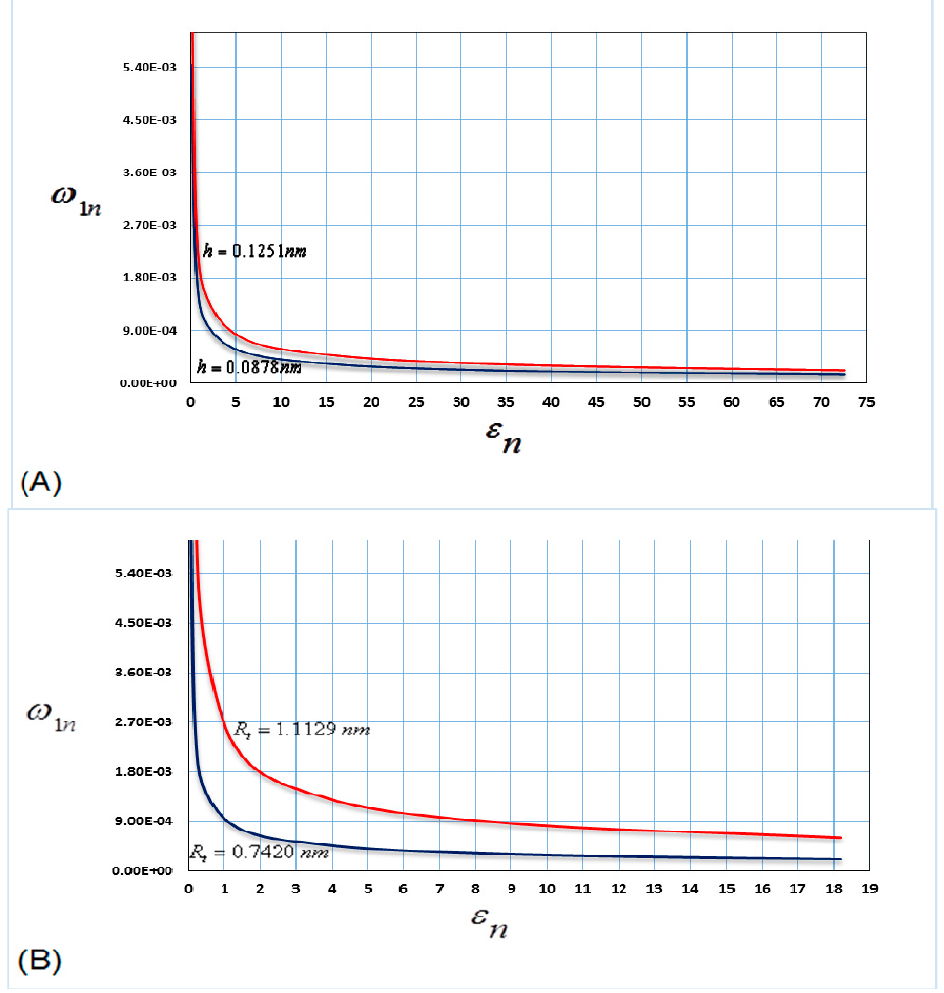
Figure 2. Nonlinear parameters versus frequency for the first mode of vibrations ( A ) h = 0.0878 nm, h = 0.1251 nm and ( B ) R t = 0.7420 nm, R t = 1.1129